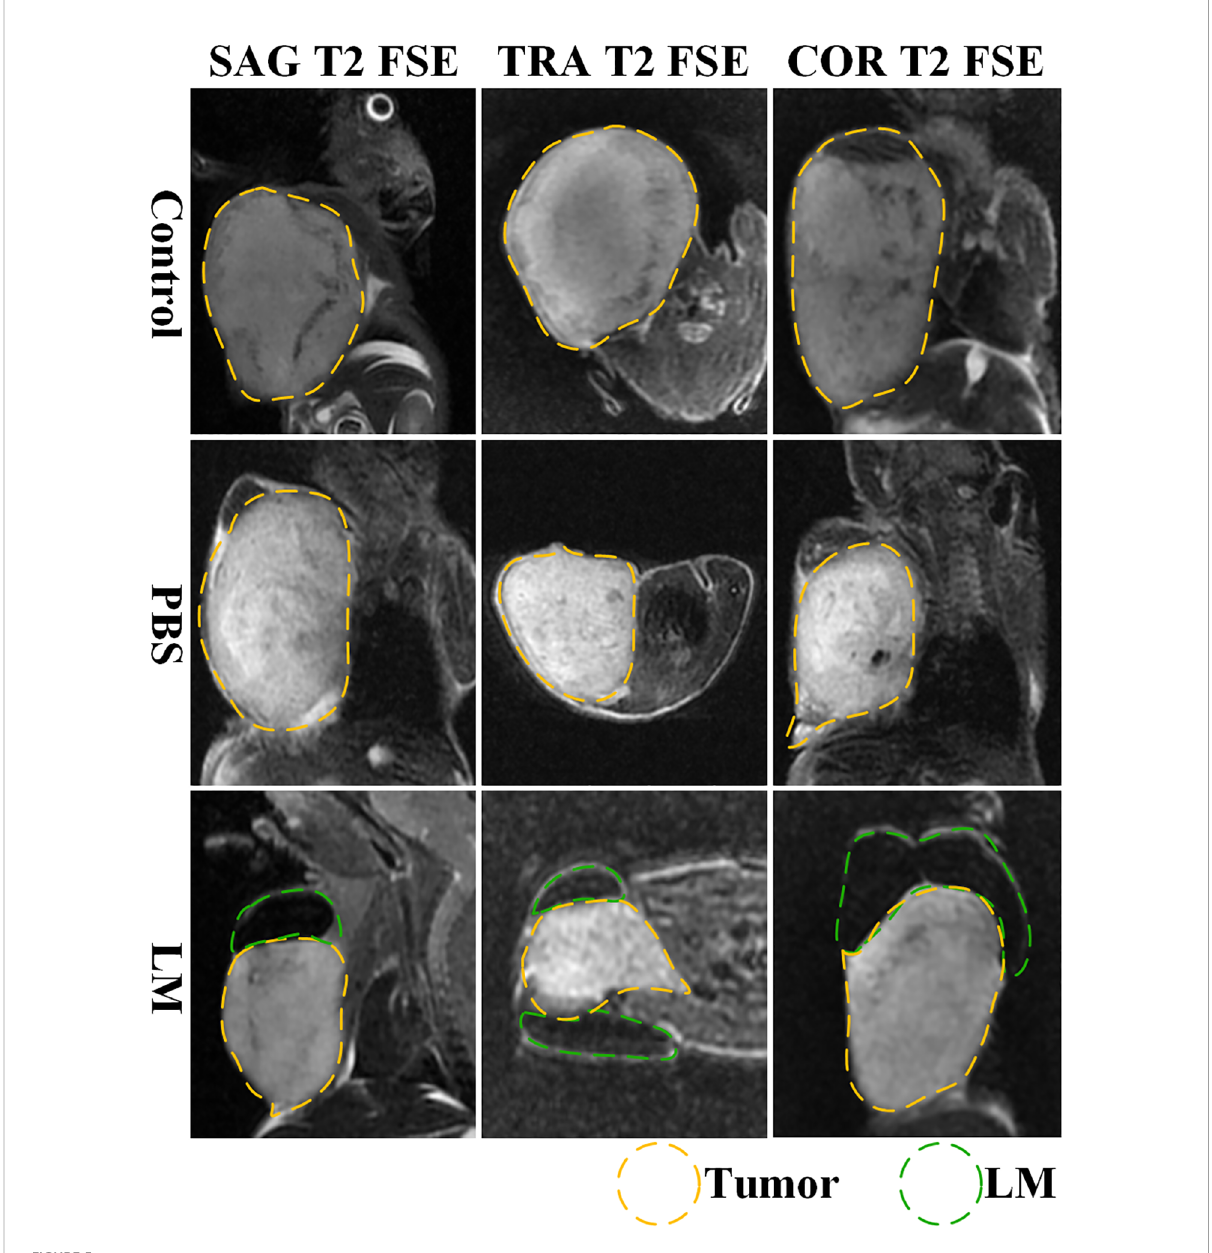
FIGURE 5 The T2WI tomography images of axial, coronal and sagittal of tumor-bearing mice in each group. Tumor is marked by yellow dotted lines, LM is marked by green dotted lines. SAG T2 FSE, sagittal positions fast spin echo sequences; TRA T2 FSE, axial positions fast spin echo sequences; COR T2 FSE, coronal positions fast spin echo